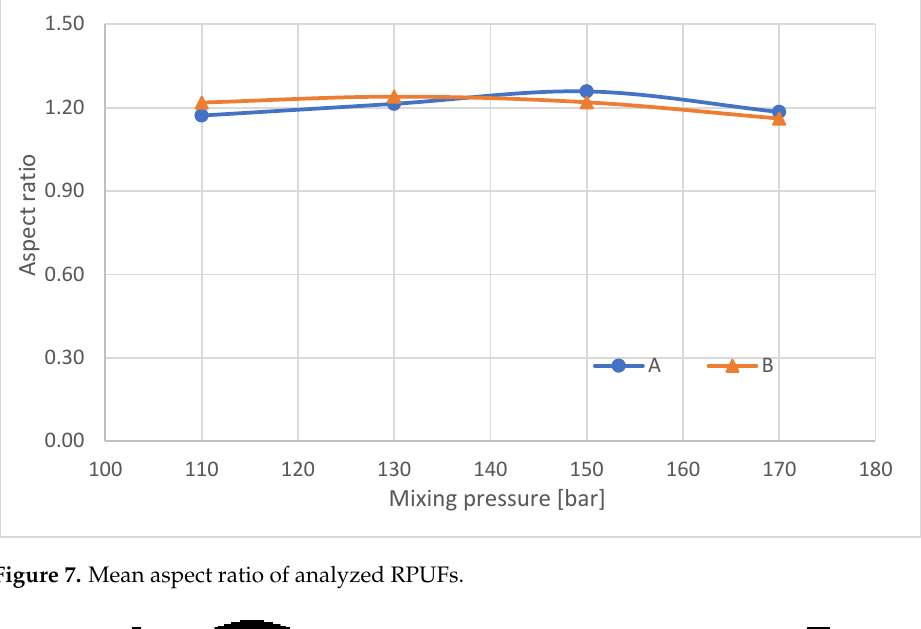
Figure 7. Mean aspect ratio of analyzed RPUFs.